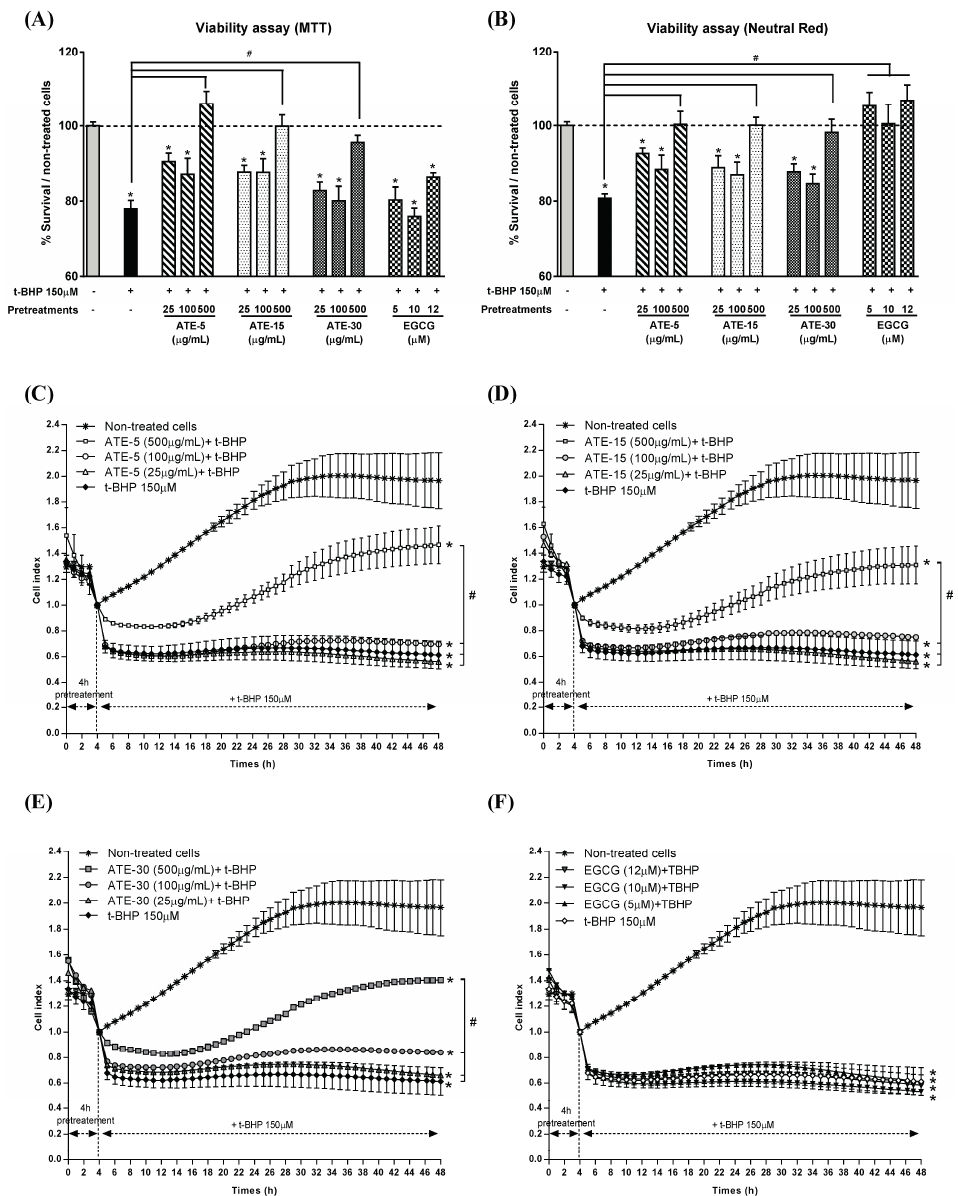
Figure 3. Effect of ATE or EGCG on the viability of rat hepatocytes. Cell viability was assessed by the MTT ( A ) and neutral red uptake (NRU) test ( B ) after 4 h pretreatment with 25, 100 and 500 µg/mL tea extracts or 5, 10 and 12 µM EGCG followed by 1 h exposure to 150 µM t -BHP. MTT and NRU results are presented as % viability over non-treated cells (mean ± SEM of three separate experiments; note: * p < 0.05 when compared to non-treated cells, # p < 0.05 when compared to non-pretreated + t -BHP treated cells; − indicates the absence of t -BHP or ATE, and + indicates the presence of t -BHP, in the culture medium). For cell impedance tests ( C – F ), cells were pretreated for 4 h with 25, 100 and 500 µg/mL of tea extracts or 5, 10 and 12 µM EGCG, and incubated for 44 h with t -BHP at 150 µM. Cell impedance was measured in real-time (RTCI) and cell index was normalized prior the addition of t -BHP. Results are means ± SEM for triplicates of one experiment and are representative of three independent experiments (note: * p < 0.05 when compared to non-treated cells, # p < 0.05 when compared to non-pretreated + t -BHP treated